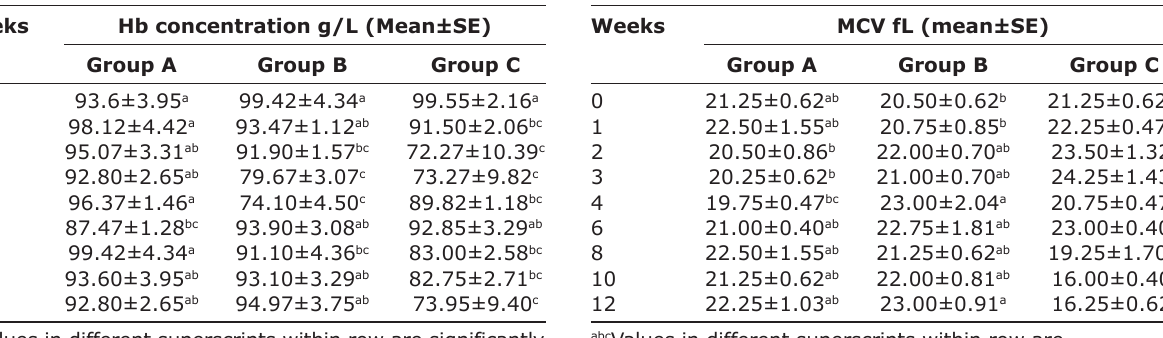
Table-4: MCV in female goat’s postinoculation with C. pseudotuberculosis and